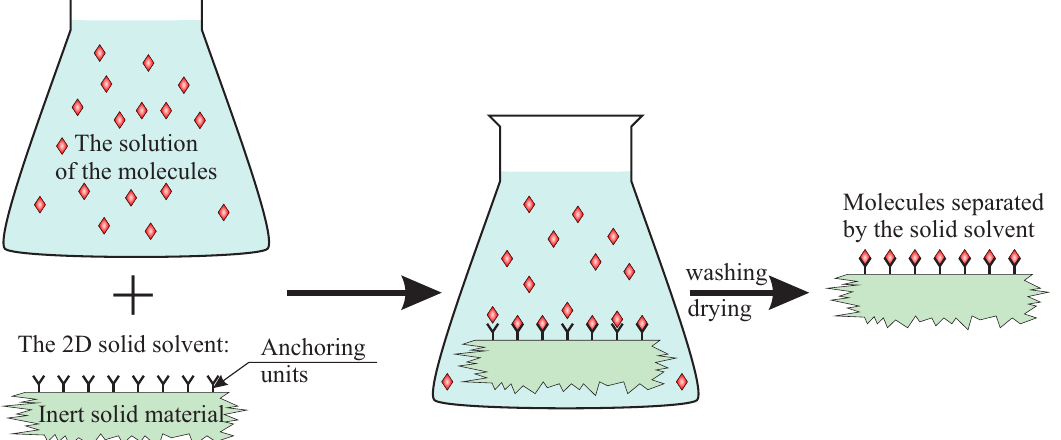
Figure 1. The scheme illustrating the proposed idea of a 2D solid